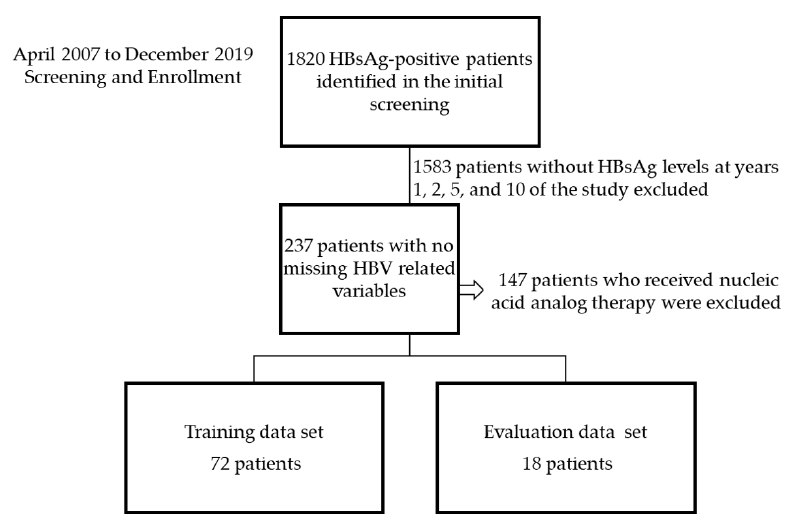
Figure 4. Flow chart of patient selection. HBV, hepatitis B virus; HBsAg, hepatitis B surface anti- gen.